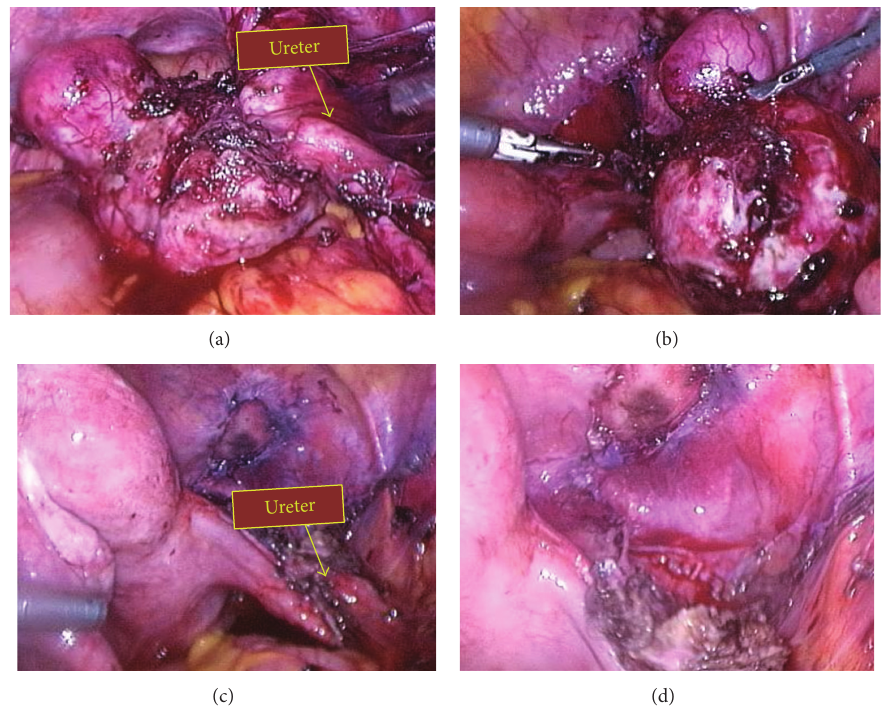
Figure 3: Ureteral course identification and